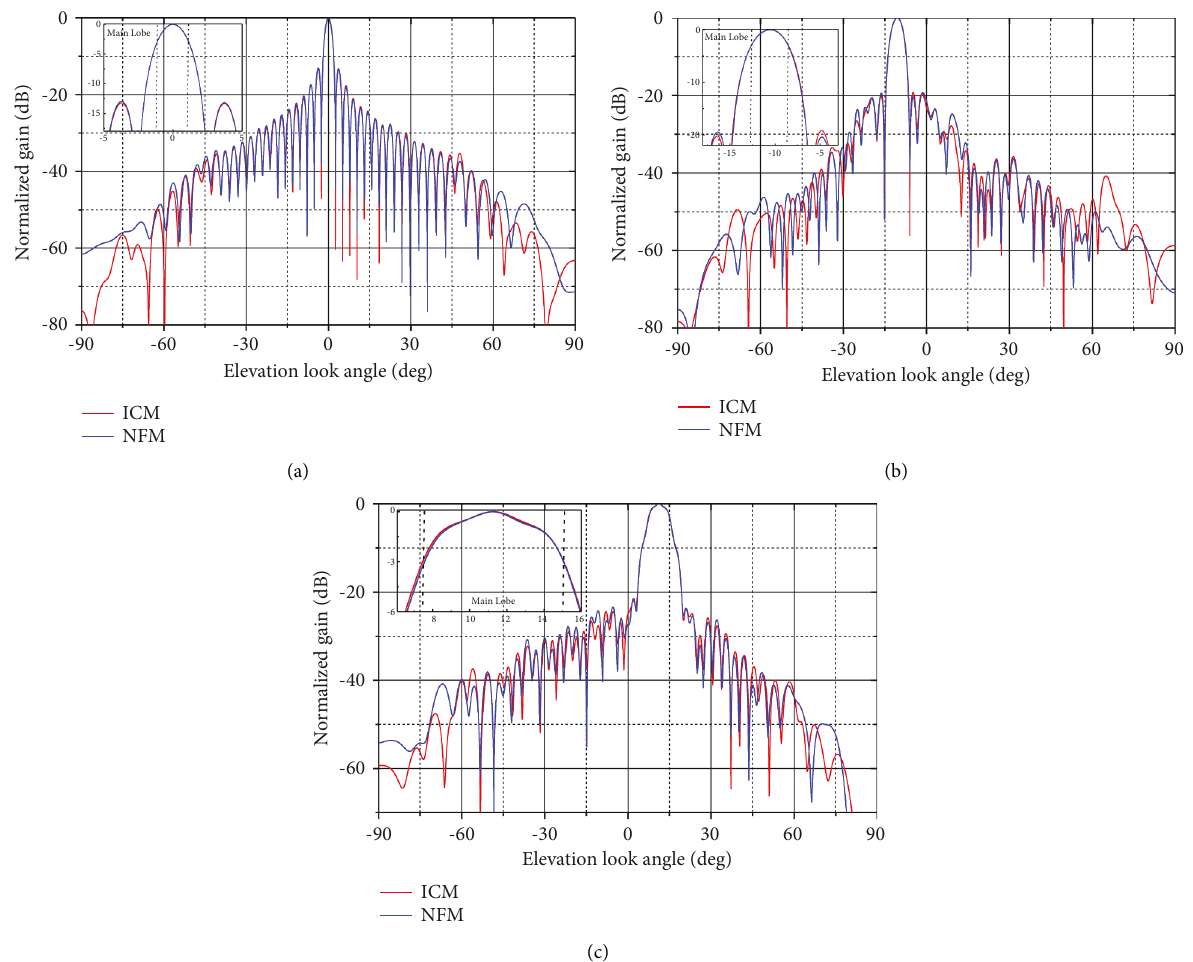
Figure 7: Elevation pattern comparison of the internal calibration method (ICM) to the near-field method (NFM). (a) Boresight beam. (b) Beam scanning and broadening 1.8 times. (c) Beam scanning and broadening 3.4 times. The inserts are the zoomed plots of the main lobe.